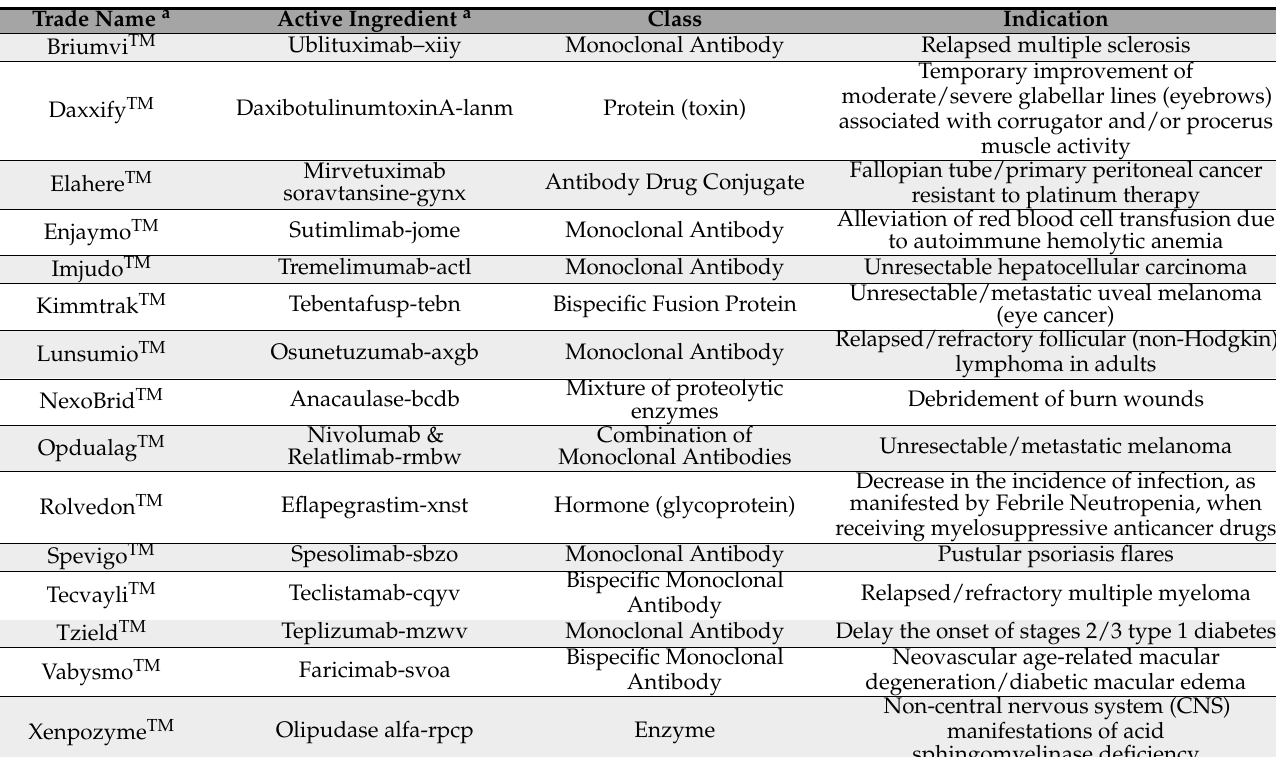
Table 1. Biologics approved by the FDA in 2022